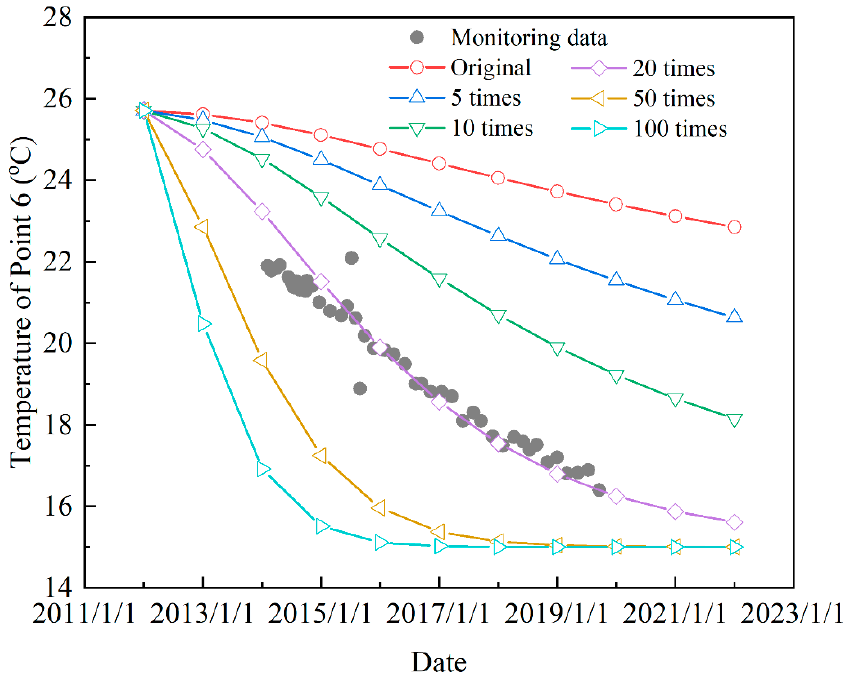
Figure 15. Temperature at Point 6 in bedrock with different permeabilities varies with water storage date.